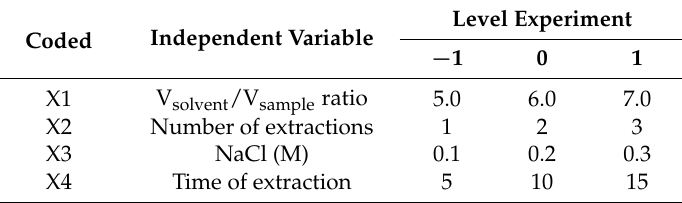
Table 1. Independent variable and experiment